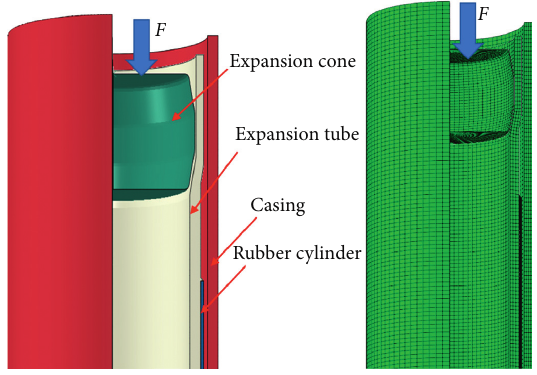
Figure 5: The FE model of expandable liner hanger.